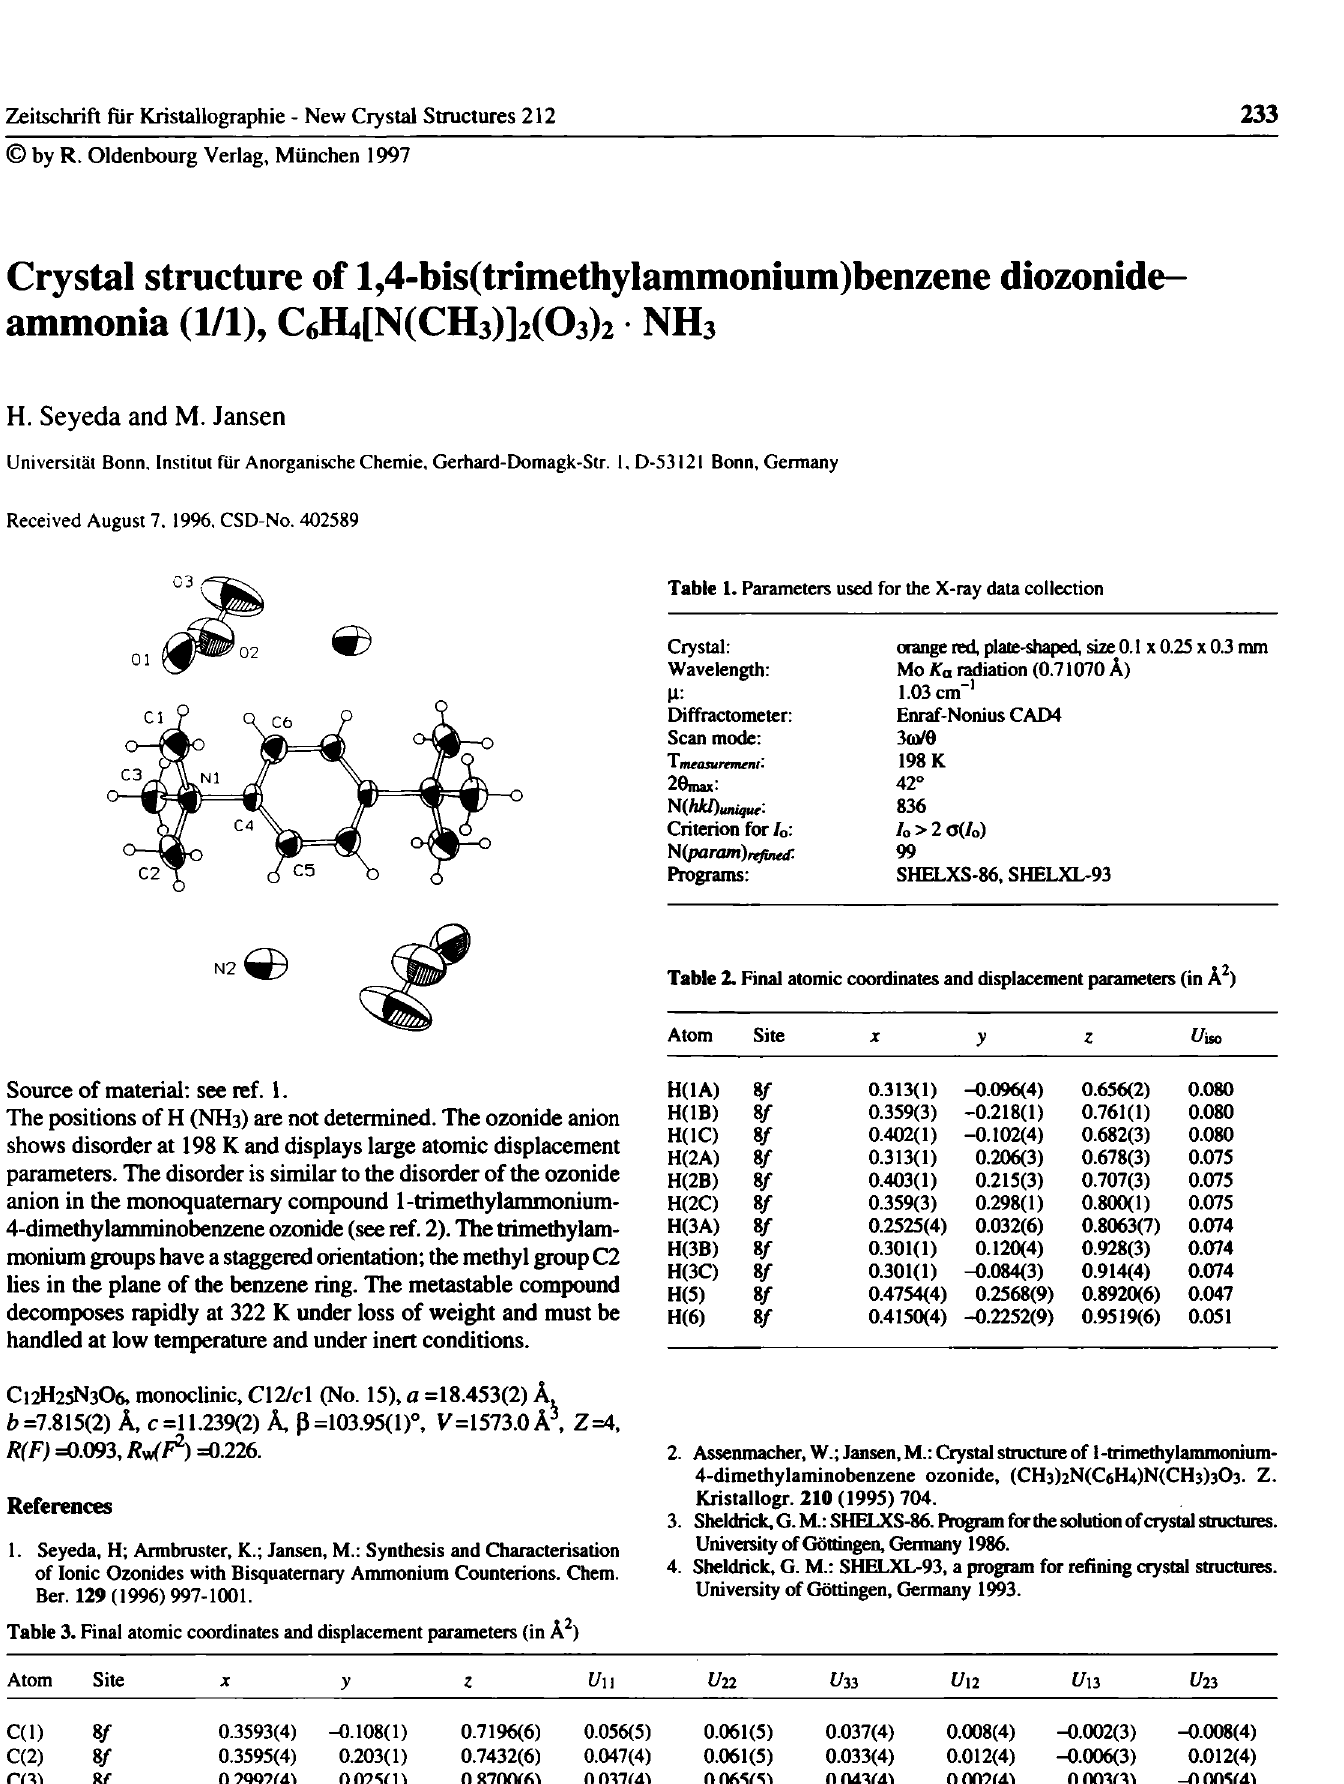
Table 3. Final atomic coordinates and displacement parameters (in Â 2 )